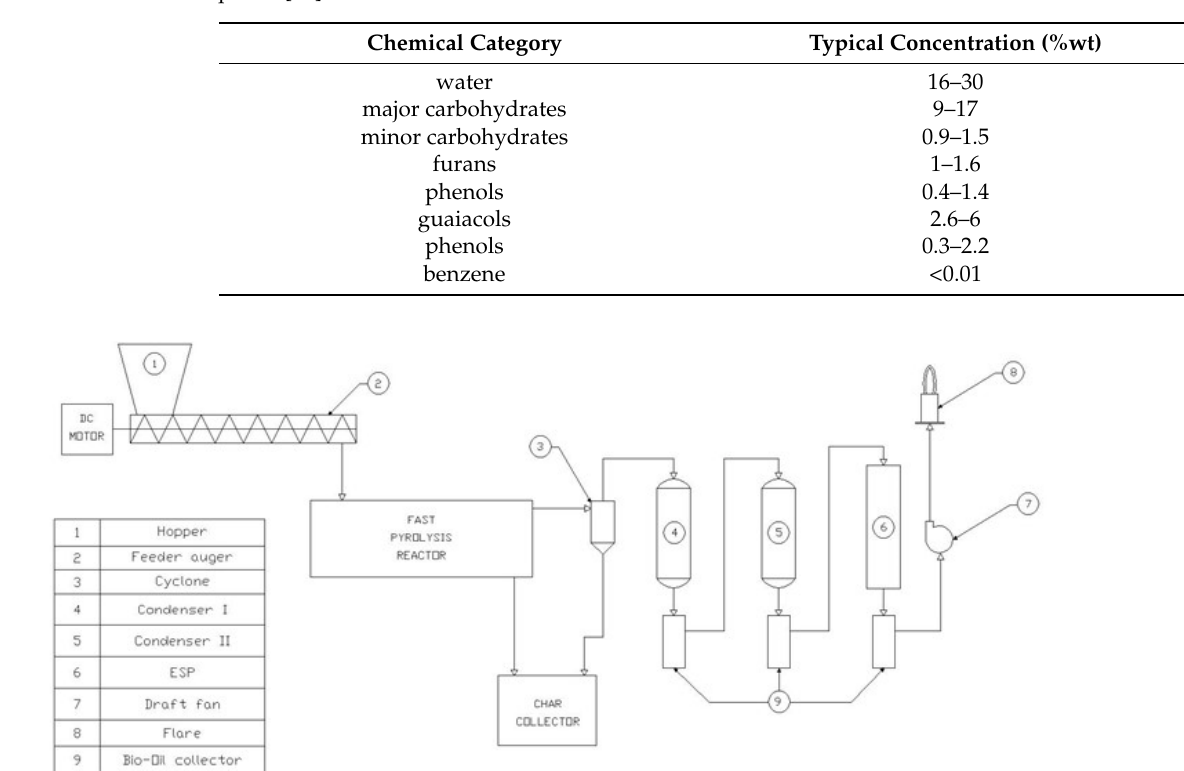
Table 2. Typical concentration of compounds included in bio-oils derived from 4 different commercial plants [21].